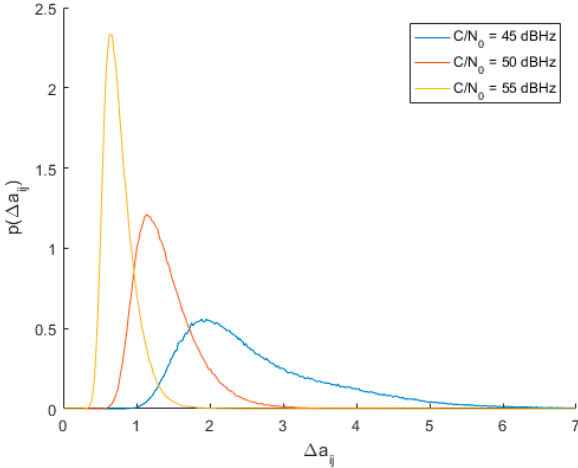
Figure 5. Empirical PDFs of spoofing steering vector distance for different C/N 0 values. Table 2. Probability of spoofing detection with ∆𝐚 (cid:3047)(cid:3035)(cid:3045) = 3.6.